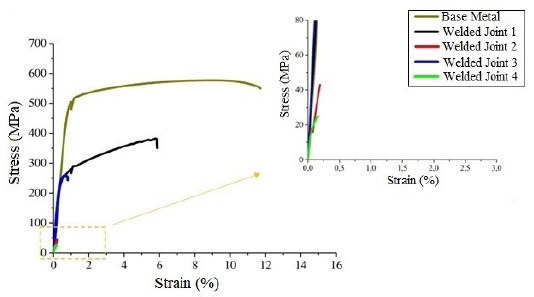
Figure 11. BM and welded joints stress-strain curves.